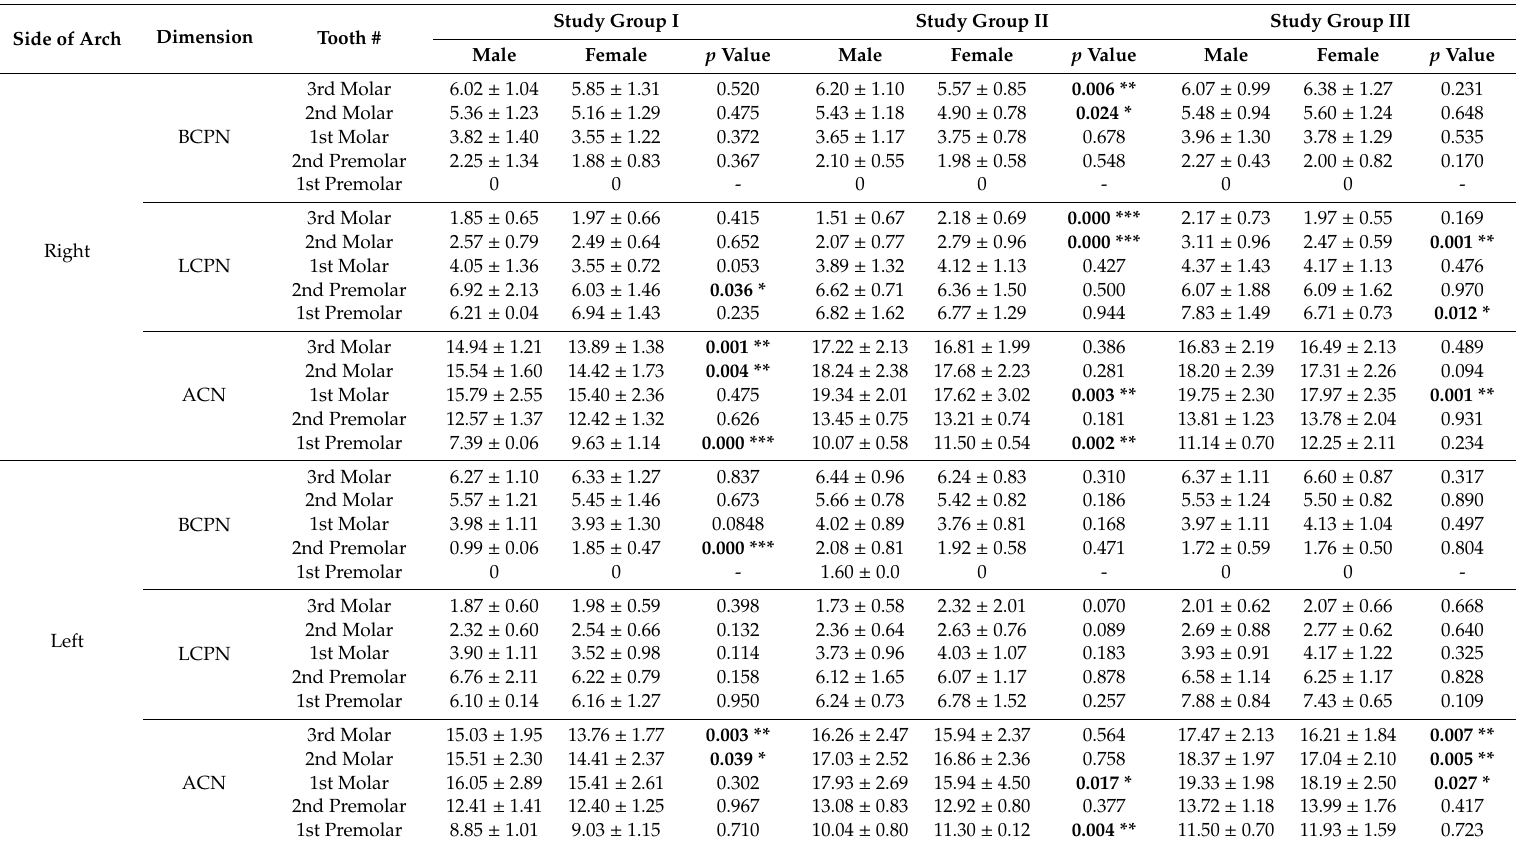
Table 3. BCPN, LCPN and ACN dimensions compared among gender measured in millimeters (mm) and presented as mean ± SD. Study Group I Study Group II Side of Arch Dimension Tooth #